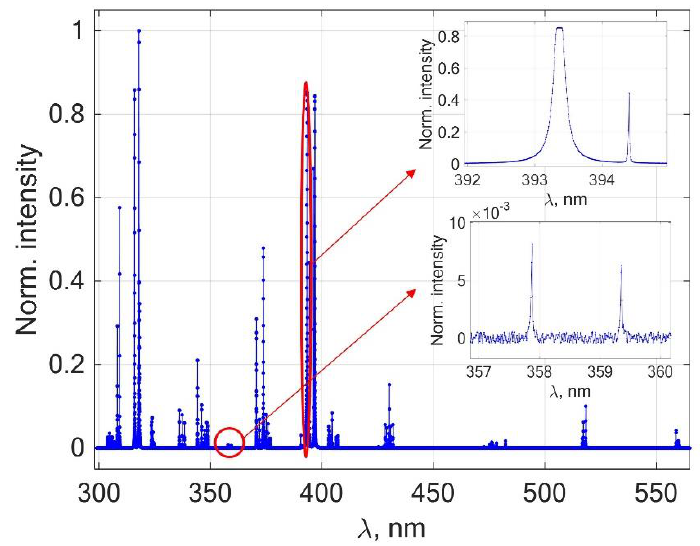
Figure 1. Synthetic spectrum of a metallurgical slag sample.